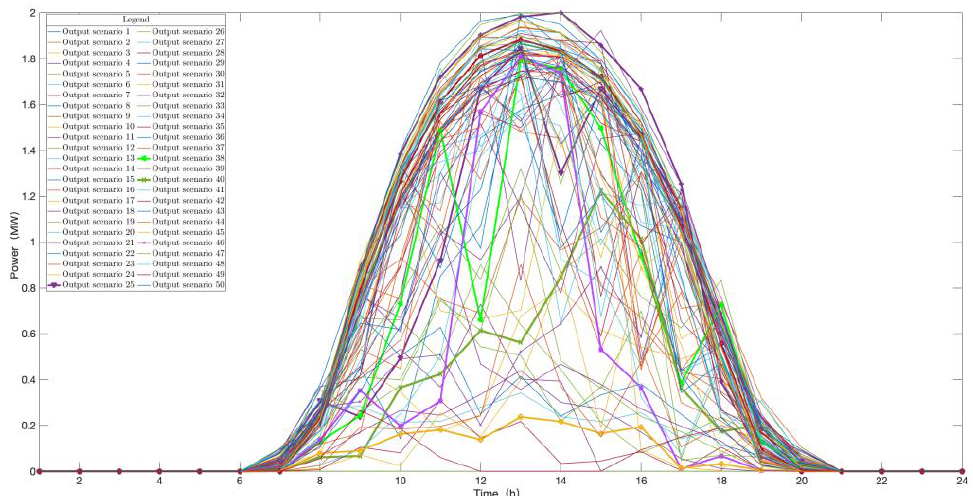
Figure A4. Clustering results of distributed solar power.